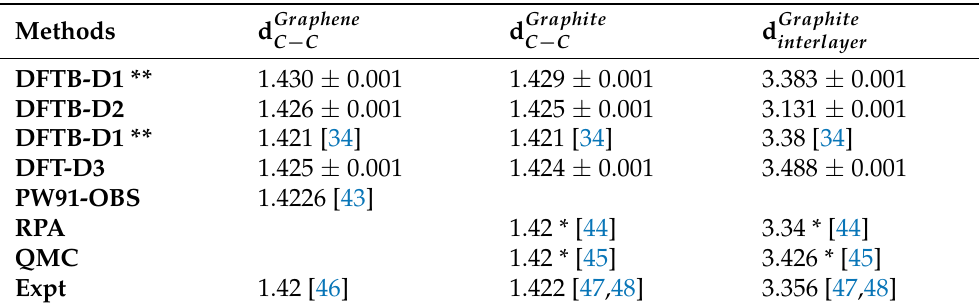
Table 1. Graphene and Graphite structural data (in Å). * In these computational studies, d C − C distance was fixed to the one determined experimentally. ** Differences between the two DFTB-D1 calculations are detailed in the